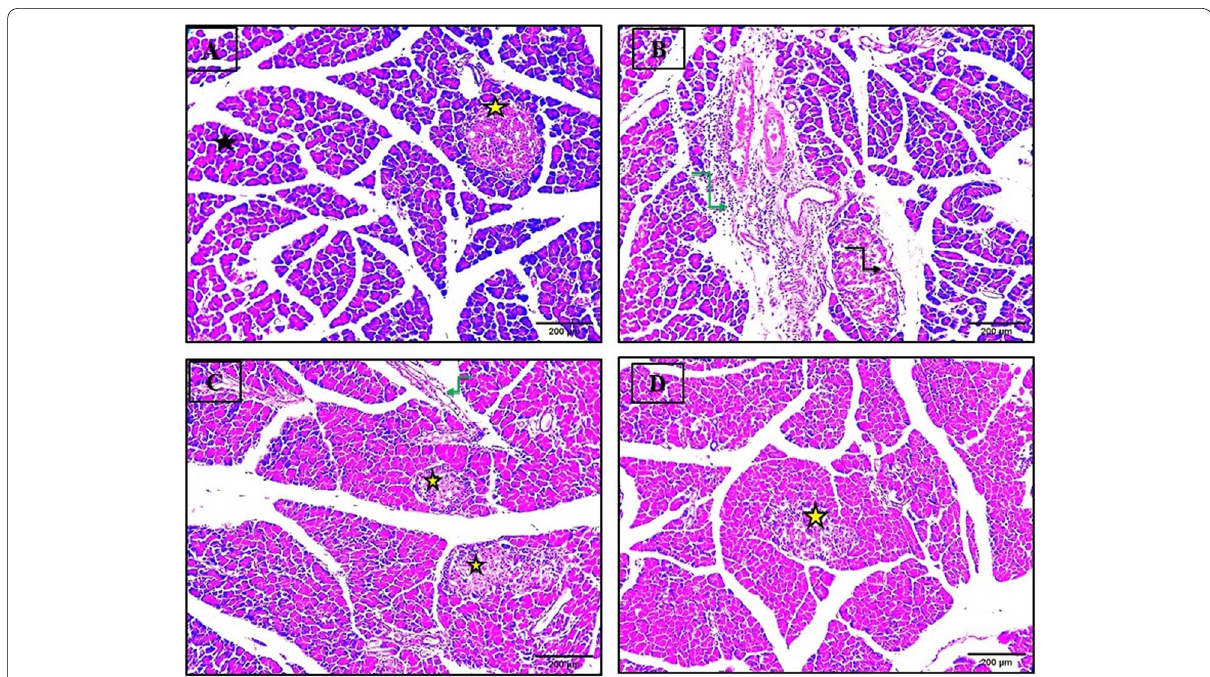
Fig. 10 Histological section of the pancreas tissue. A Normal control rat showed intact pancreatic parenchyma (black star) and normal presentation of islets of Langerhans (yellow star). B The pancreatic tissue of untreated diabetic rat showed degenerated and disintegrated islets of Langerhans (black arrow) and heavy inflammatory cell infiltrations (green arrow). C The pancreatic tissue of diabetic rat infused with hDPSCs showed normal pancreatic parenchyma (yellow star) with few inflammatory cell infiltration (green arrow). D The pancreatic tissue of diabetic rat infused with hPDLSCs showed moderate sized islets of Langerhans (yellow star) and some inflammatory cell infiltration (scale bar